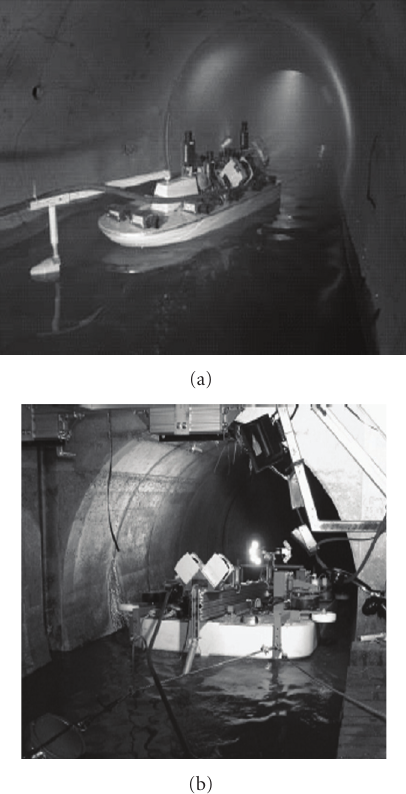
Figure 6: (a) SEK prototype; (b) SVM. Photos from [84]. Courtesy of IWA